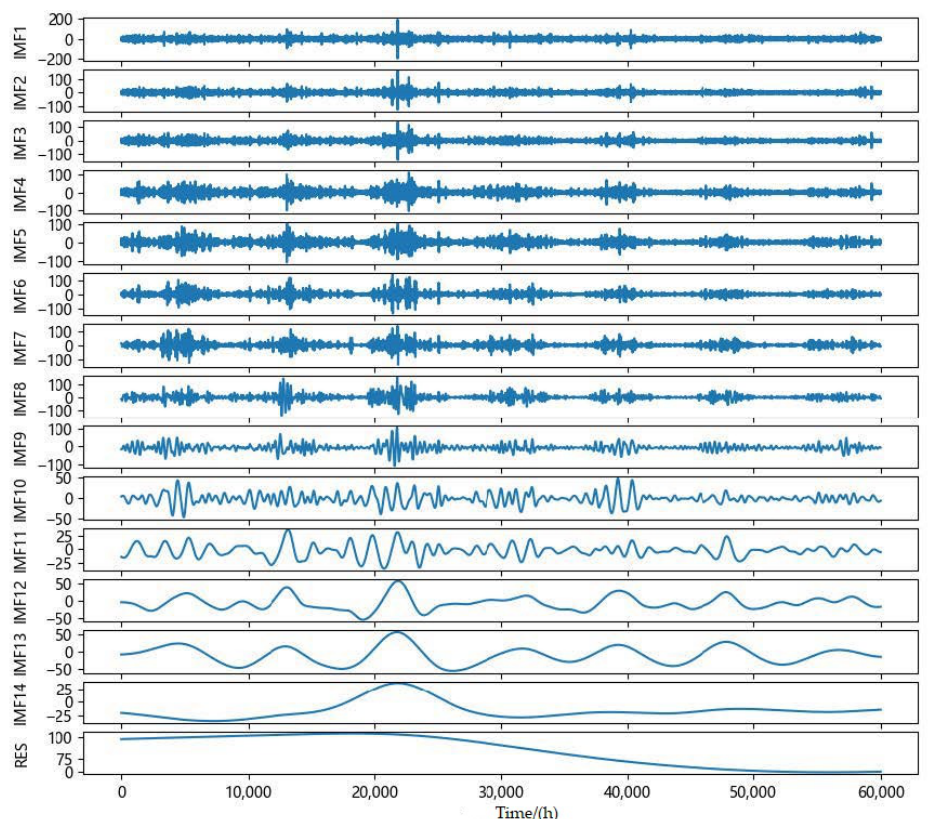
Figure 4. EEMD decomposition results of PM2.5 concentration. Table 1. The period of each IMF component of PM2.5